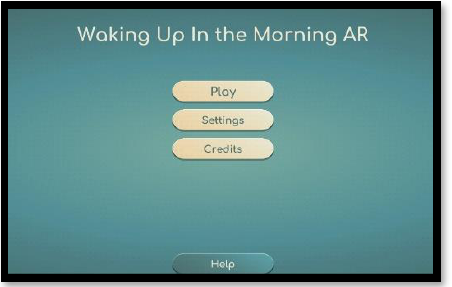
Figure 24. WUIM-AR UI for tablet.